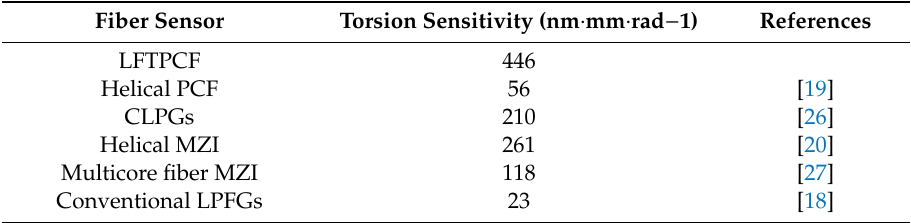
Table 3. Torsion sensitivities of several fiber